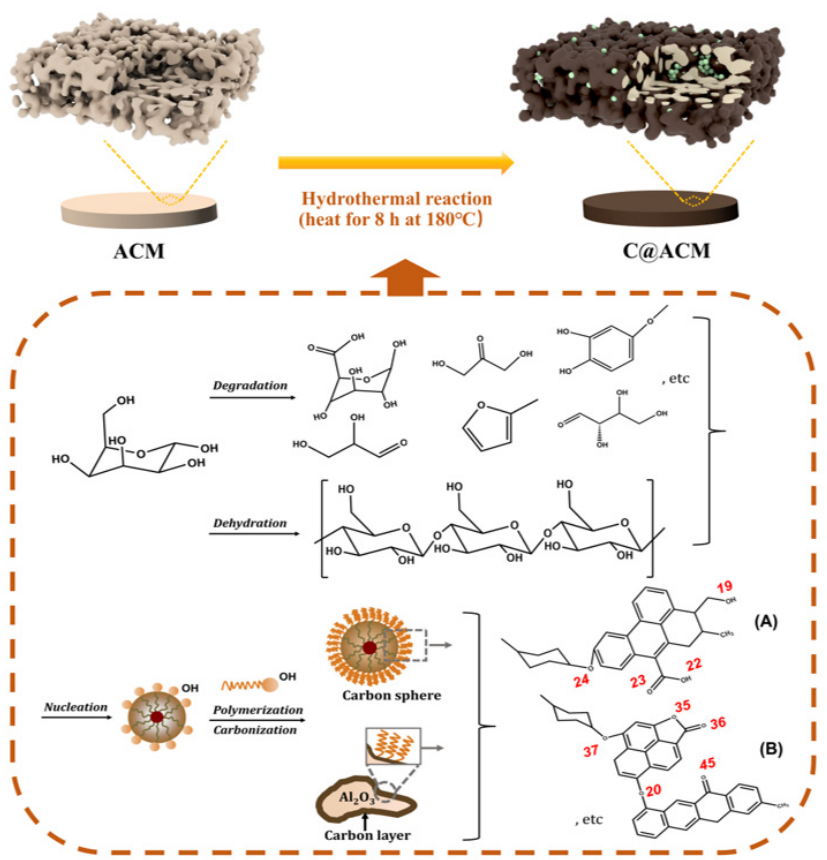
Figure 2. Fabrication of C@ACM by the hydrothermal method and the reaction mechanism. (The white porous structure represents the ACM, the black shell represents the carbon layer, and the green spheres represent the carbon spheres. A and B were the typical products, and they were further applied in the Milluiken charges calculation with Gaussian 09W software).